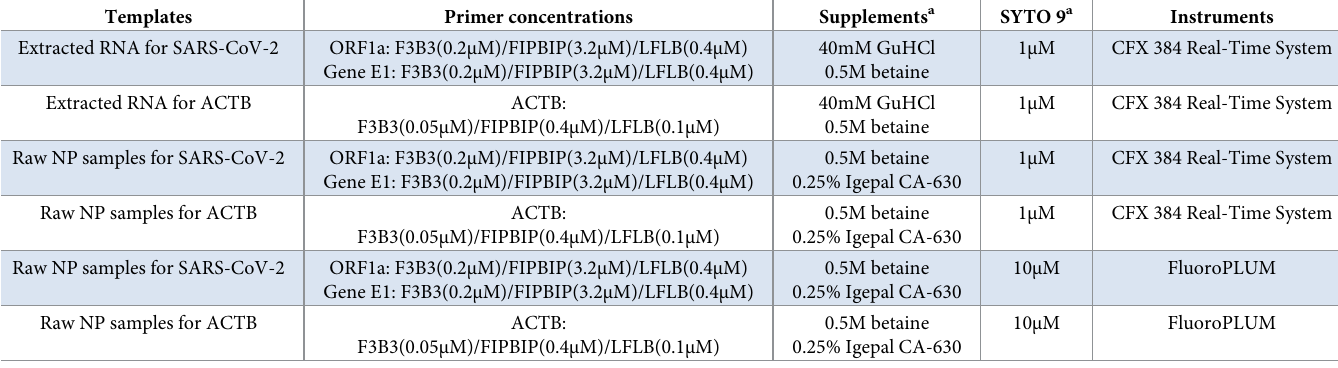
Table 2. Optimized RT-LAMP